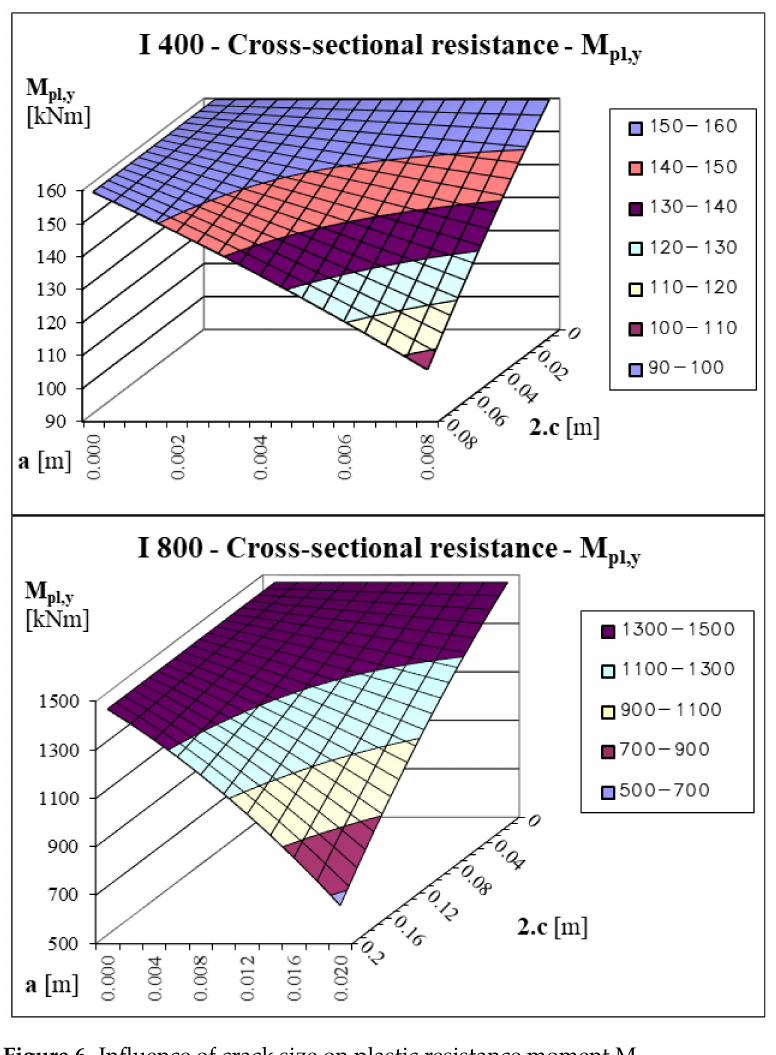
Figure 6. Influence of crack size on plastic resistance moment M pl,y . Table 2. Statistical characteristics of welded steel beams I 400 and I